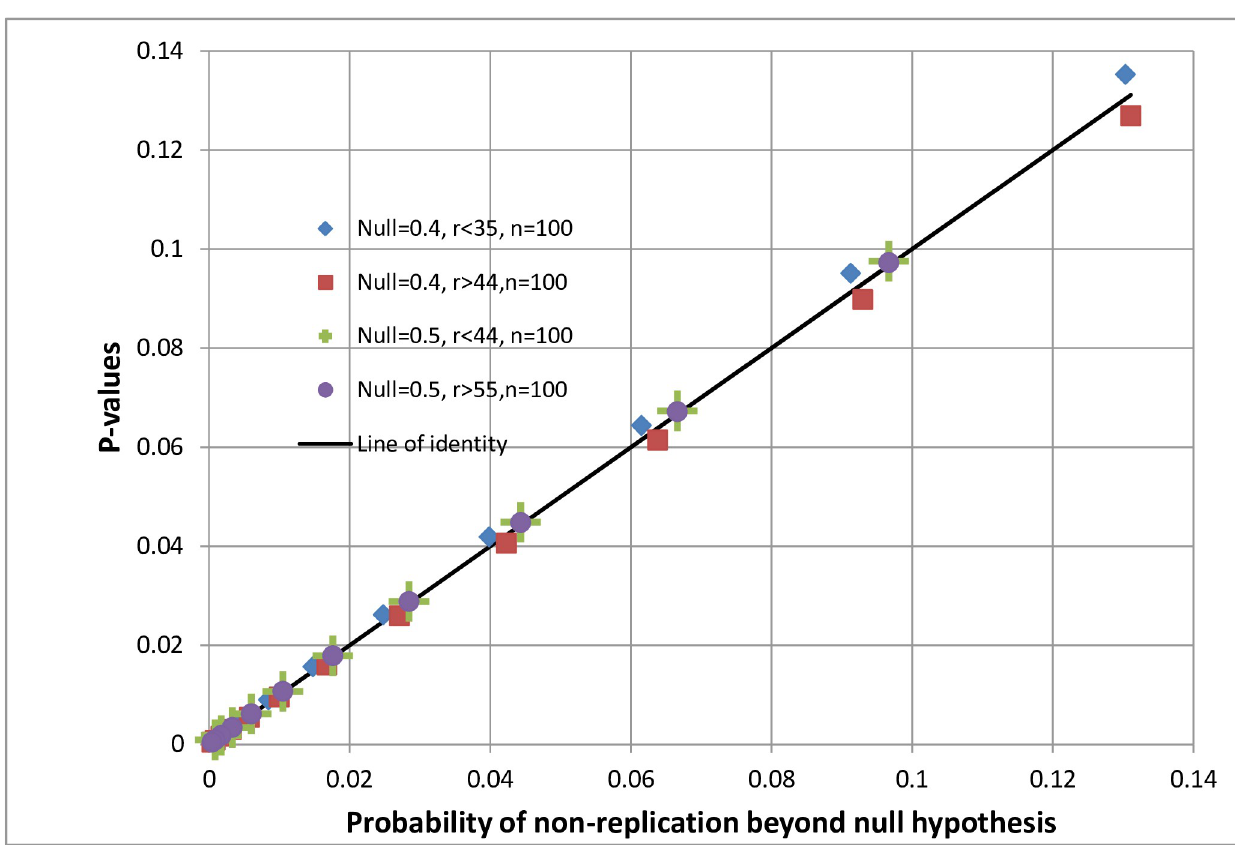
Fig 5. Comparison of probabilities of non-replication for observed proportions of r/100 with one-sided P-values for different null hypotheses of 0.5 and 0.4.